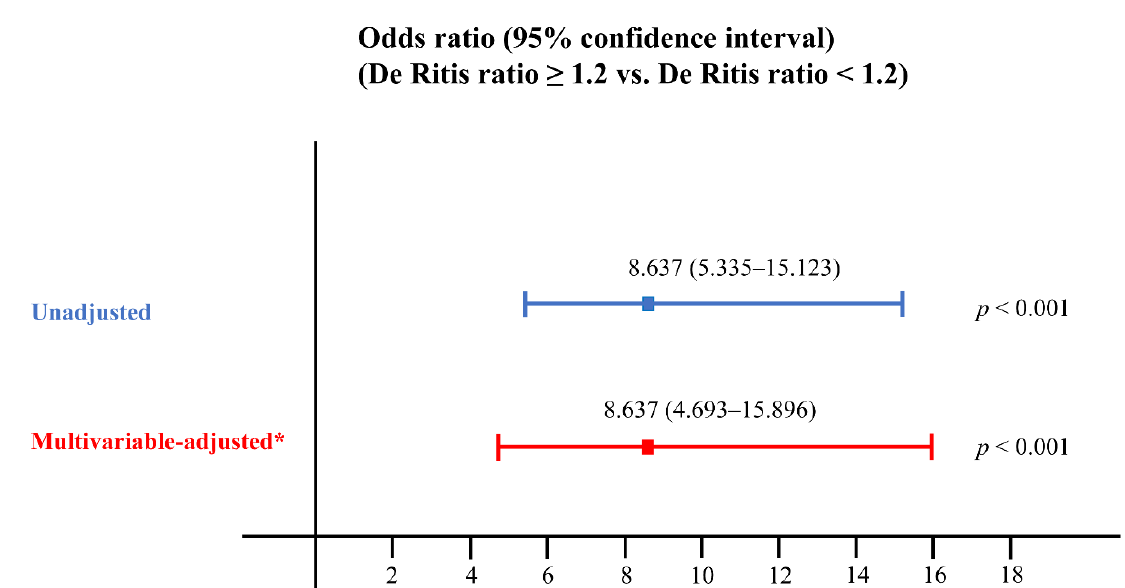
Figure 3. A De Ritis ratio ≥ 1.2 can predict AKI after RRP. The multivariable-adjusted odds ratio was determined using the variables shown in Table 3. The De Ritis ratio was calculated by dividing the AST concentration by the ALT concentration. AKI, acute kidney injury; RRP, radical retropubic prostatectomy; AST, aspartate aminotransferase; ALT, alanine aminotransferase.